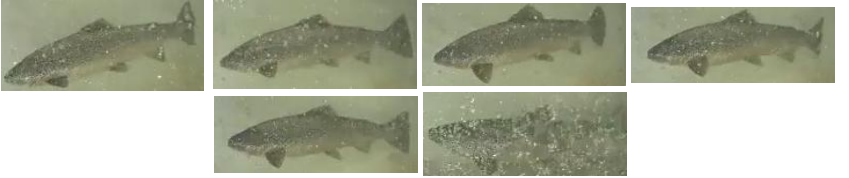
Figure 2. Appearance and shape variations of fish ID 344 from a video recording as it swam from right to left frame number 260, 418, 421, 426, 452, and 474,